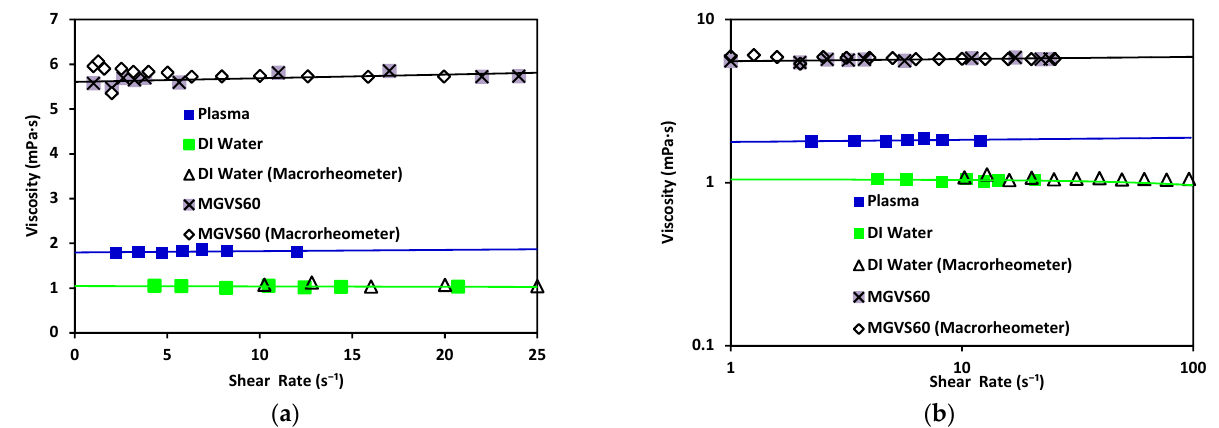
Figure 7. Viscosity vs. shear rate using the microrheometer for DI water (green) and standard MGVS60, and using the macrorheometer: ( a ) linear scale and ( b ) log–log scale.